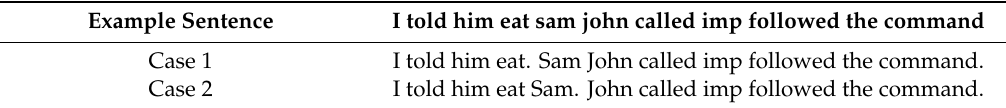
Table 1. An example of distinction (segmentation) ambiguity in STT-generated sentences without periods and capital